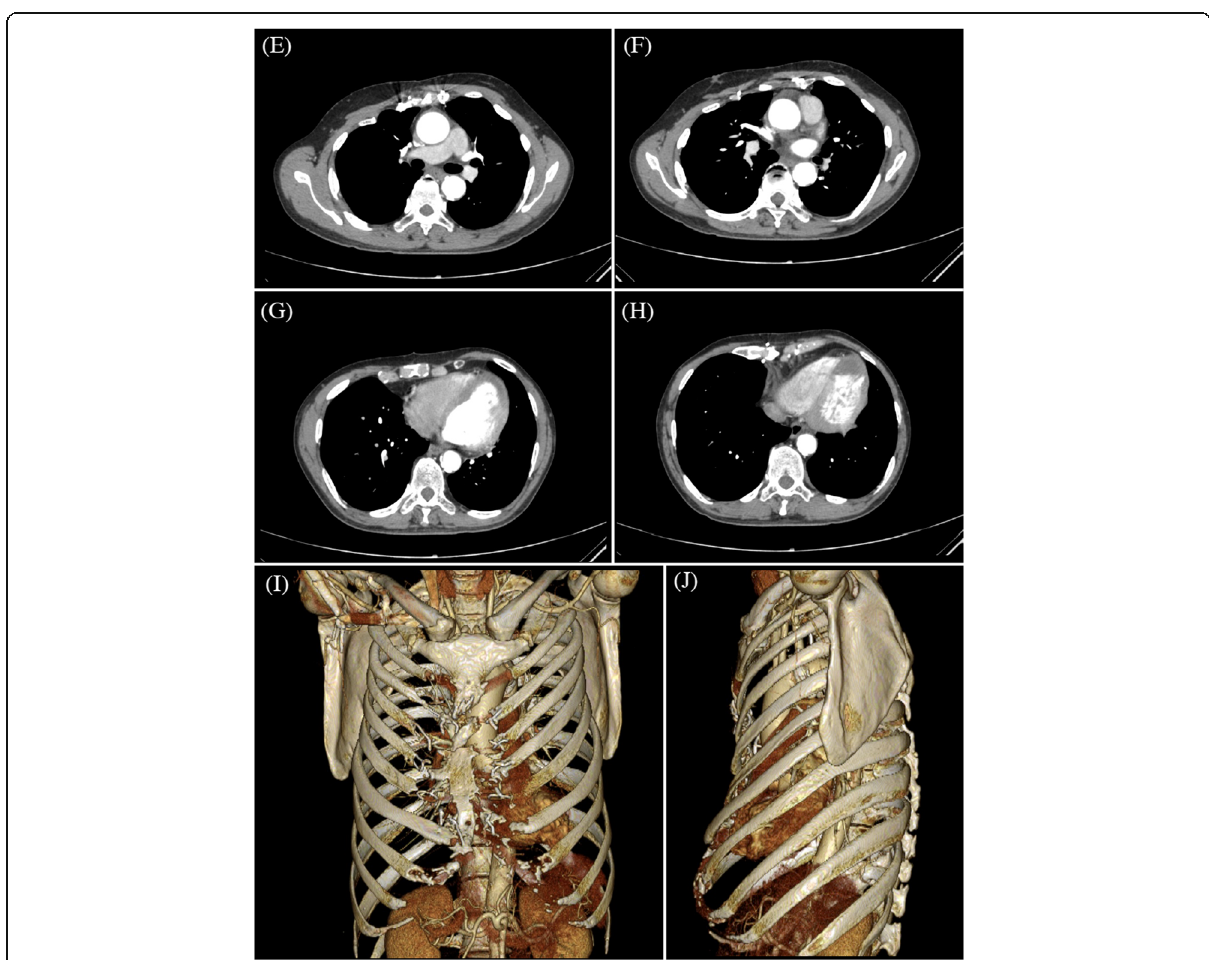
Fig. 2 Preoperative axial ( e – h ) and three-dimensional ( i , j ) computed tomography shows bilateral occlusion of the internal thoracic arteries and a small fragile sternum after sternoturnover fixation